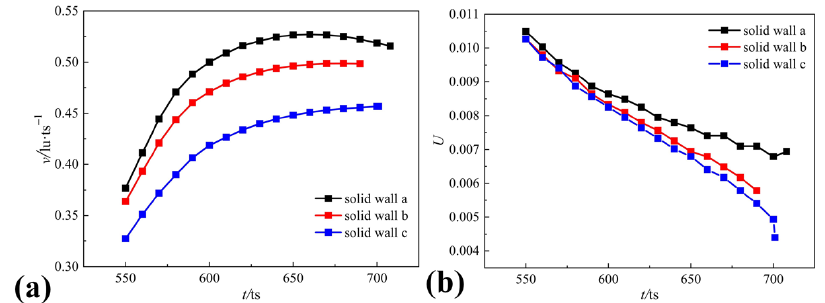
Figure 14. Jet velocity and boundary length vs. time under the same fractal dimension: ( a ) jet velocity and ( b ) boundary length.